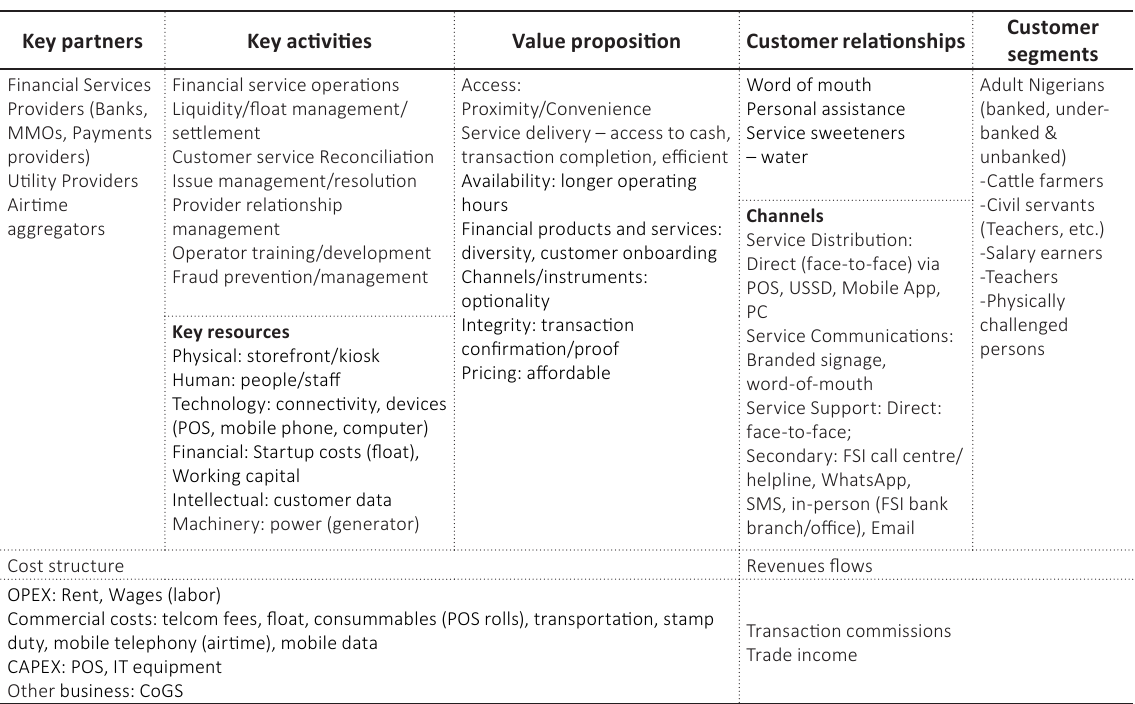
Table 2. CANVAS models for insurance